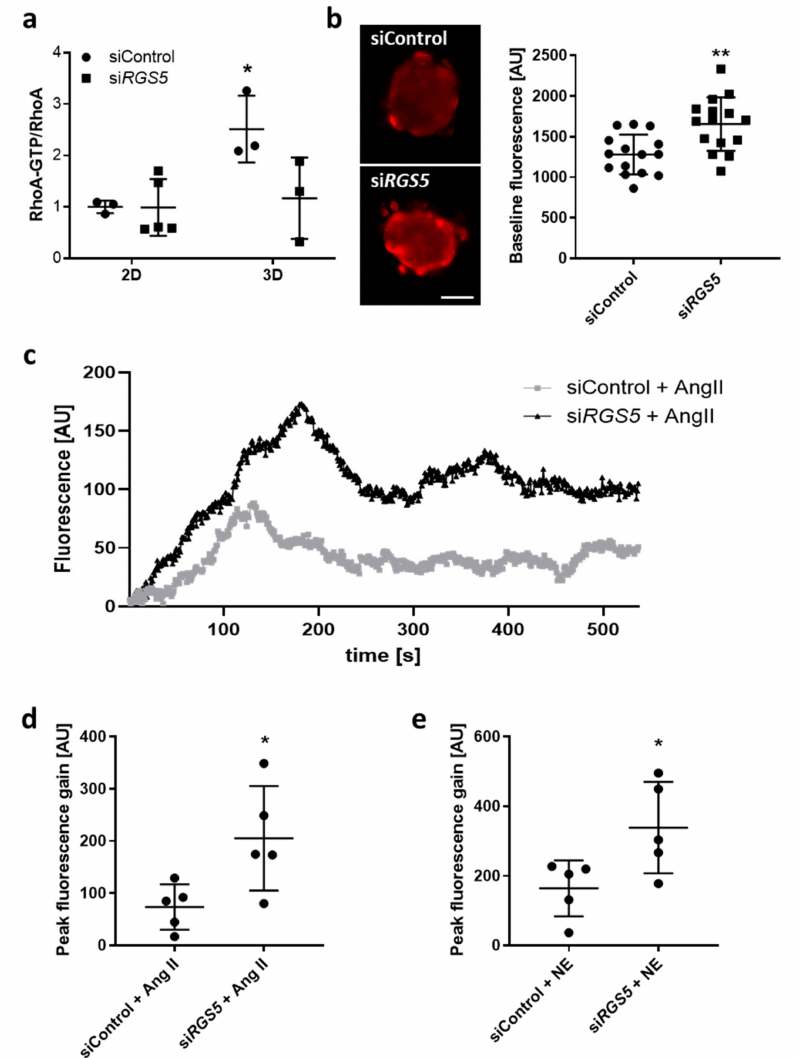
Figure 4. Loss of RGS5 inhibits RhoA -activity and elevates calcium levels in human VSMC spheroids. RGS5 was depleted in HUASMC using siRNA-mediated transfection. Cells were further cultured as either monolayer (2D) or spheroids (3D). ( a ) Analysis of RhoA-GTP/RhoA applying a RhoA G-LISA. Total RhoA protein levels were determined using immunoblot-based techniques (* p < 0.05 vs. siControl, n = 3–5). ( b – e ) Three-dimensional (3D) spheroids were loaded with Rhodamin-4 to monitor the calcium-triggered change in fluorescence. ( b ) Representative image and corresponding quantification of the baseline calcium levels in HUASMC spheroids upon knockdown of Rgs5 (** p < 0.01, results of 15 spheroids per group, scale bar: 50 µ m). ( c ) Representative recordings of the angiotensin II (Ang II)-induced change of the fluorescence in spheroids upon knockdown of Rgs5 vs. control conditions. ( d , e ) Corresponding quantification of the peak fluorescence gain (vs. baseline) in 3D spheroids (* p < 0.05, n = 5) upon treatment with Ang II or norepinephrine